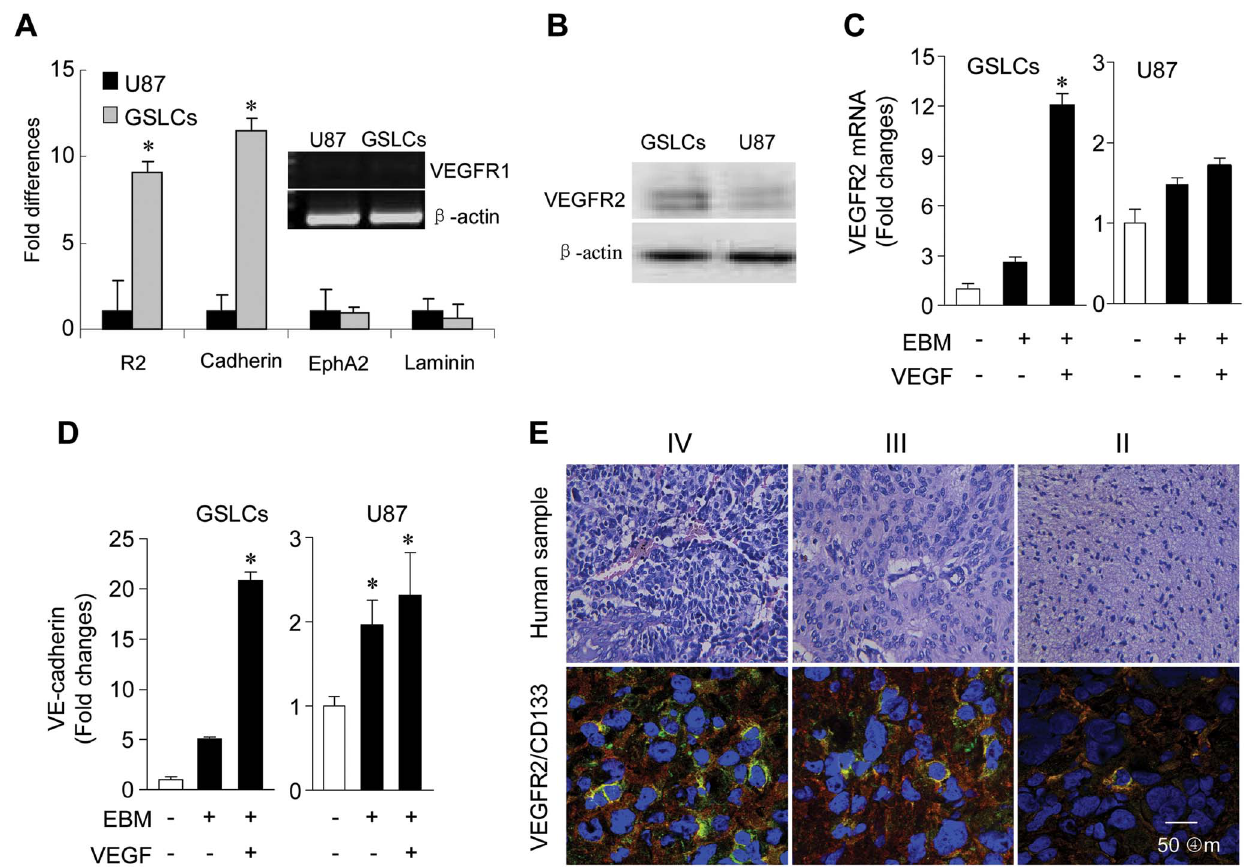
Figure 2. Preferential expression of VEGFR-2 by GSLCs isolated from U87 GBM cells. ( A ) The expression of mRNAs for VEGFR1, VEGFR-2, VE-cadherin, EphA2, and laminin 5 c 2 in GSLCs and U87 GBM cells was measured by RT-PCR or real-time RT-PCR. * Indicates significantly increased expression by GSLCs. ( B ) Western blot of VEGFR-2 (230 and 200 KDa) in GSLCs and U87 GBM cells. b -actin was used as an internal control. ( C , D ) The effect of VEGF on the expression of mRNAs for VEGFR-2 ( C ) and VE-cadherin ( D ) in GSLCs or U87 GBM cells was measured by real-time RT-PCR. * Indicates significantly increased expression of genes compared to U87 cells or by VEGF treated cells (* P , 0.01 ). ( E ) HE staining of human glioma specimens. IV: WHO Grade IV; III: WHO Grade III; II: WHO Grade II. Co-expression of CD133 (red) and VEGFR-2 (green) by human Grade IV GBM, Grade III anaplastic astrocytoma and Grade II astrocytoma sections is shown. Scale bar=50 m m.